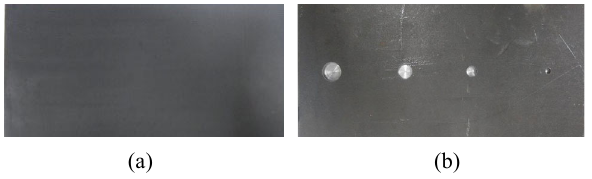
Fig. 1 Specimen 1# with four flat-bottom hole defects: (a) front surface and (b) back surface.